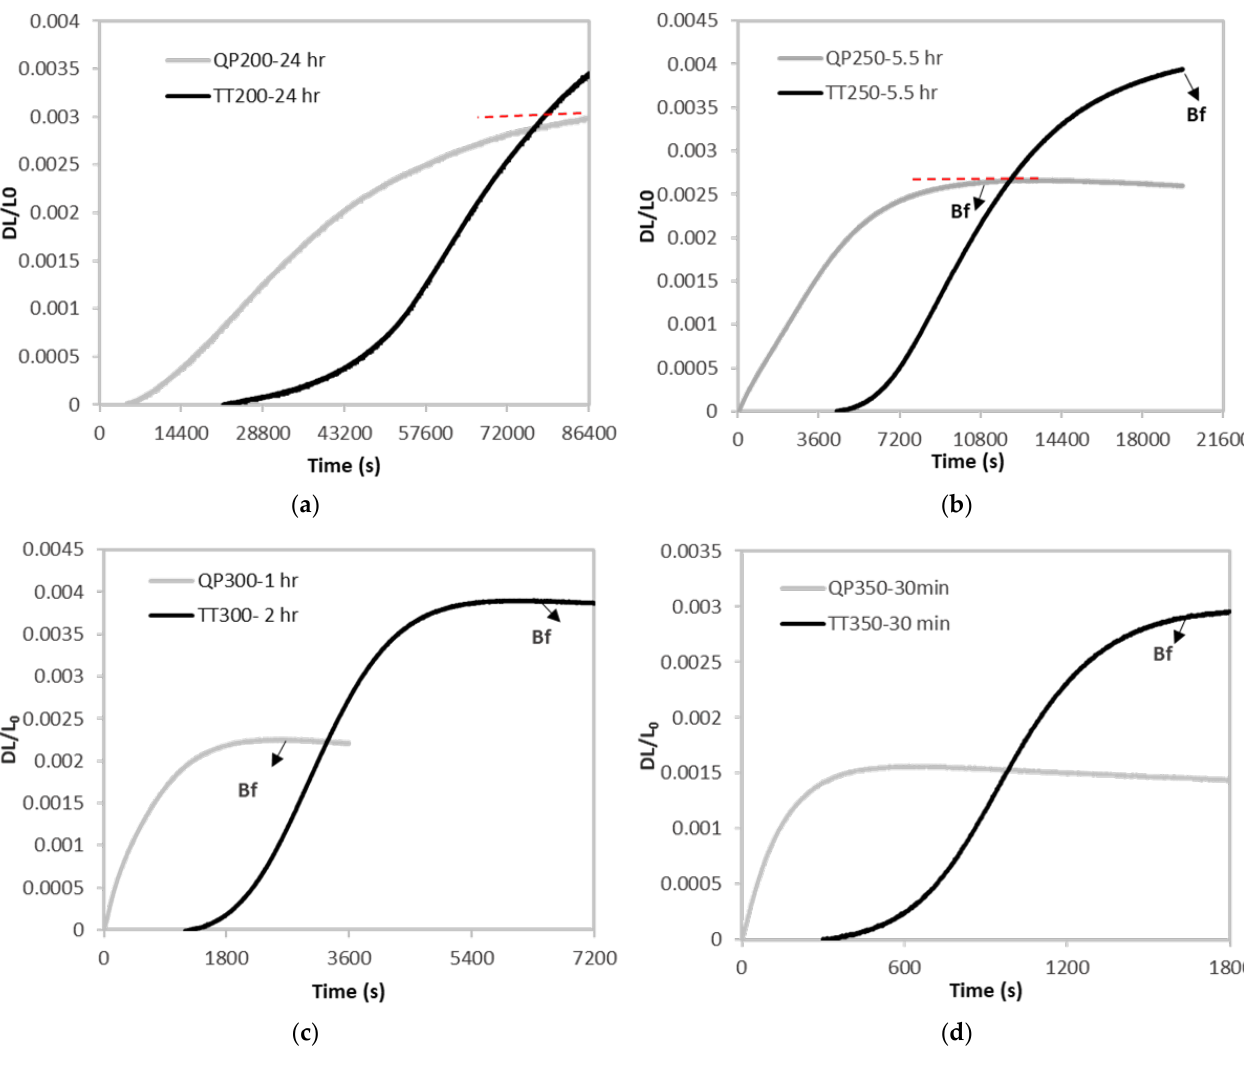
Figure 2. Dilatation during bainitic formation in one-step (TT) and two-step (QP) heat treatments: